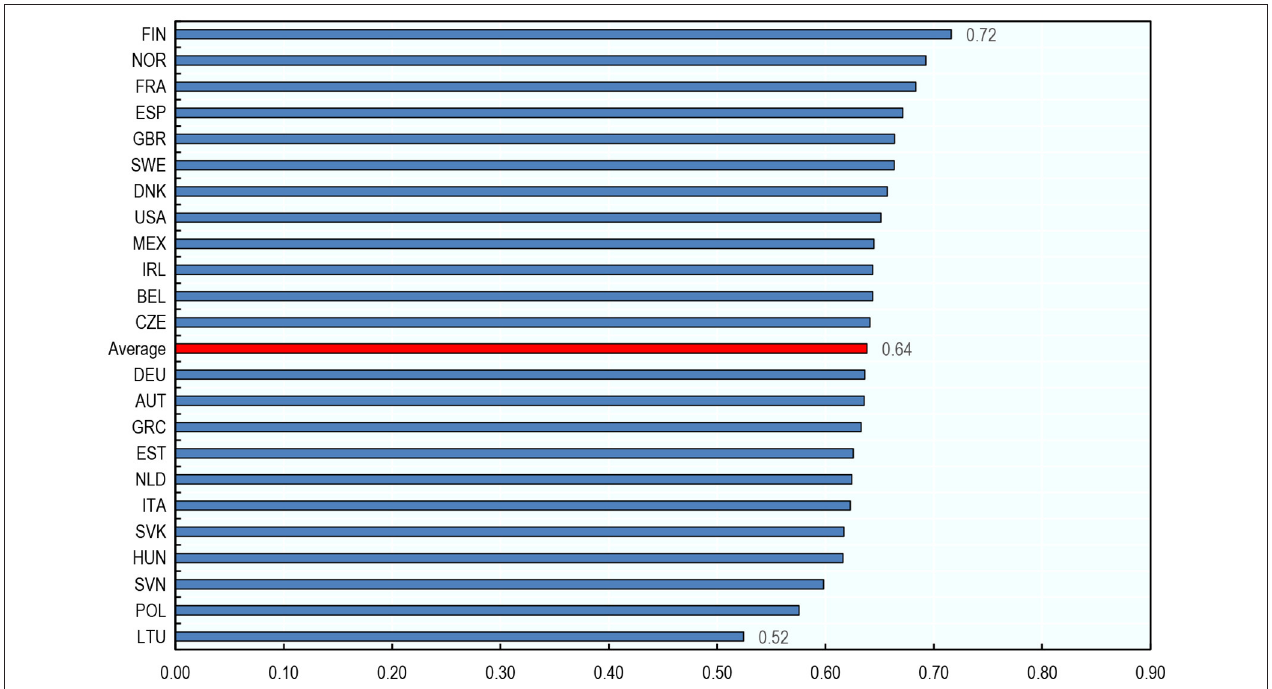
FIGURE 6 | Cross-country differences in exposure to AI for a given occupation are small compared to cross-occupation differences. Average exposure to AI across occupations by country, 2012. The averages presented are unweighted averages across the 36 occupations in the sample. Authors’ calculations using data from the Programme for the International Assessment of Adult Competencies (PIAAC) and Felten et al. (2019).